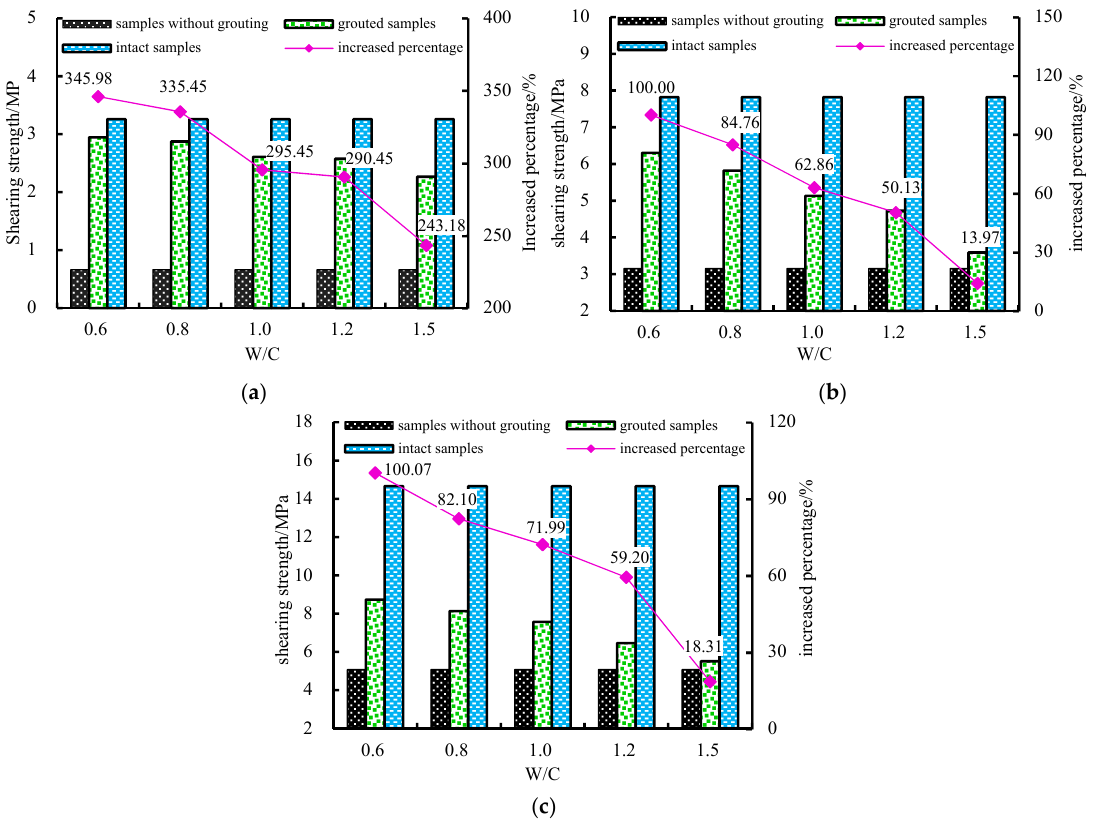
Figure 10. Grouting effect of N in different W/C : ( a ) 7 MPa samples grouting effect; ( b ) 16 MPa samples grouting effect; ( c )26 MPa samples grouting effect.